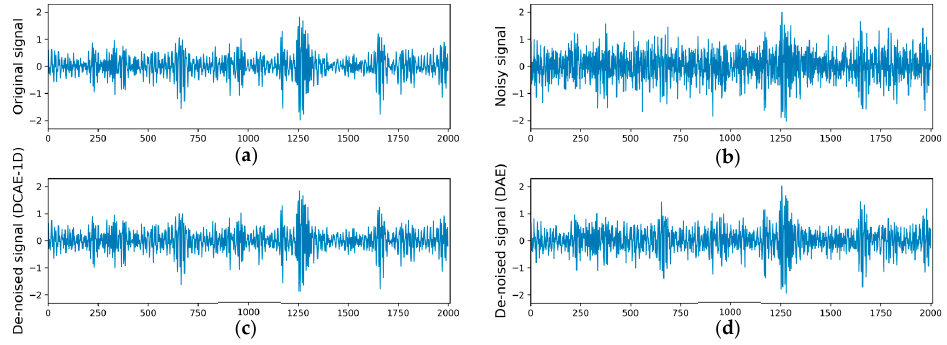
Figure 8. Figures of signals: ( a ) original signal, ( b ) original signal mixed with Gaussian noise, ( c ) de-noised signal of DACE-1D and ( d ) de-noised signal of DAE under the condition of SNR = − 1 dB and roller fault (0.54 mm).